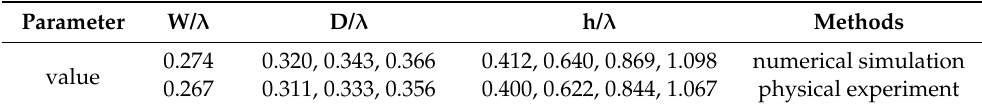
Table 3. Parameter table of wave steepness research.